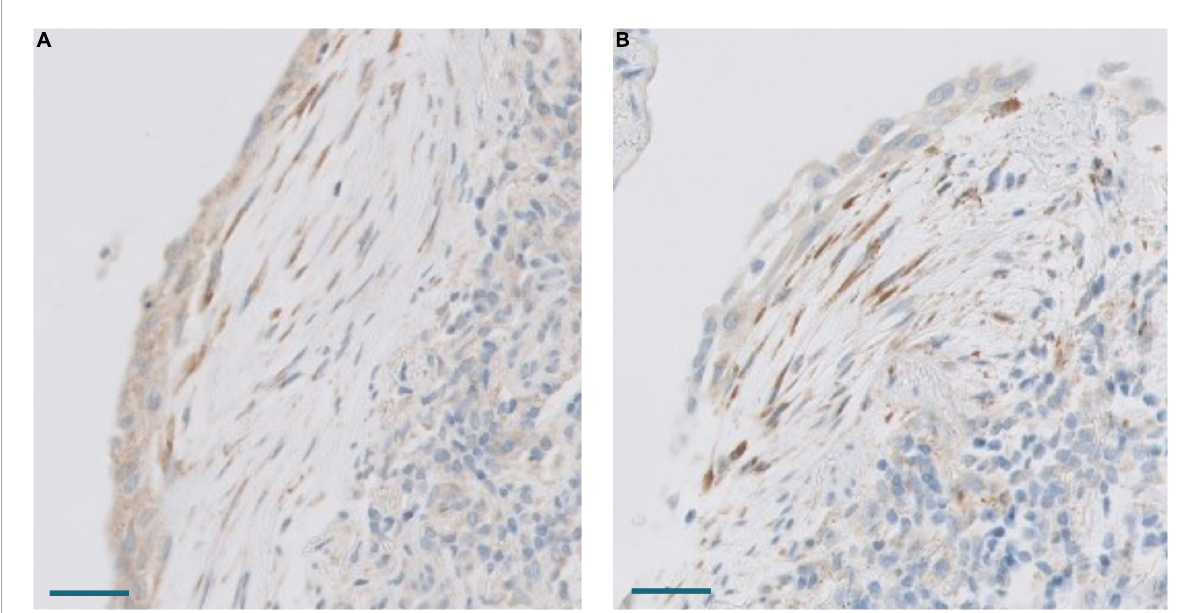
FIGURE12 (A) Expression of CTHRC1 in a fibroblastic focus. Scale bar: 100 µ m. (B) Expression of SPARC in the same fibroblastic focus. Scale bar: 100 µ